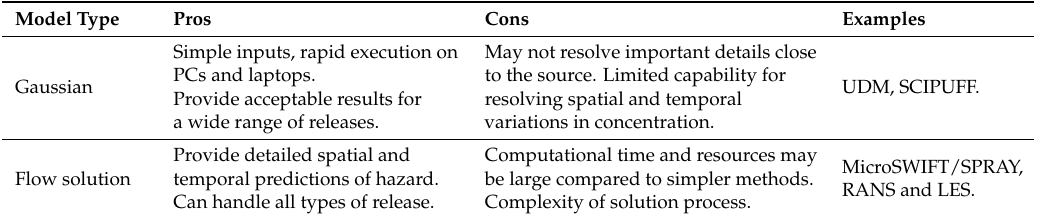
Table 1. The pros and cons of Gaussian and flow solution based atmospheric transport and dispersion (AT&D) simulation models.